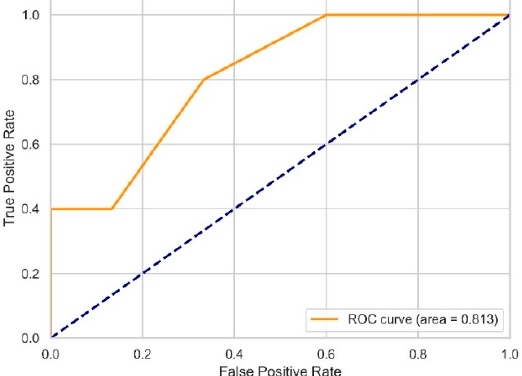
Figure 10. ROC curve and AUC score for the AHP model that produced the environmental susceptibility map of Figure 8a.